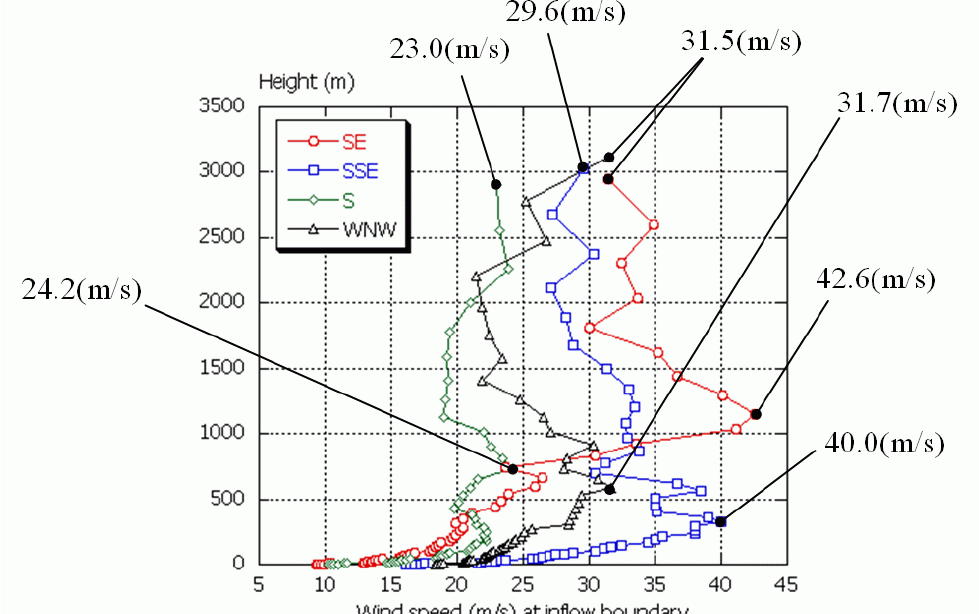
Figure 5. Results of the typhoon simulations: vertical profiles of the horizontal wind speed at the center of the inflow boundary of the computational domain from the time of the largest simulated value of the horizontal wind speed at observation pole No. 2. The wind profiles are plotted for the south-easterly, south-south-easterly, southerly, and west-north-westerly wind